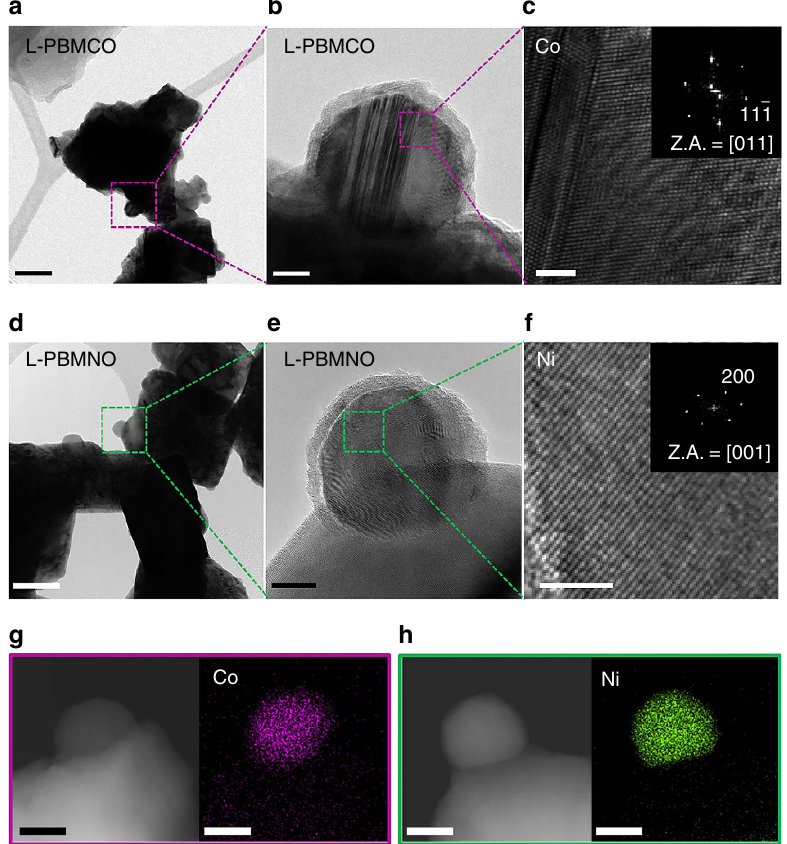
Figure 1 | Transmission electron microscopic analysis. ( a ) A bright-field (BF) TEM image; scale bar, 100nm and ( b ) high-resolution (HR) TEM image of PrBaMn 1.7 Co 0.3 O 5 þ d (L-PBMCO) sample; scale bar 10nm. ( c ) Magnified HR TEM image of exsolved Co nanoparticle; scale bar 2nm, ( d ) BF TEM image; scale bar 100nm and ( e ) HR TEM image of PrBaMn 1.7 Ni 0.3 O 5 þ d (L-PBMNO) sample; scale bar 10nm. ( f ) Magnified HR TEM image of Ni nanoparticle; scale bar 2nm. ( g ) High-angle annular dark-field (HAADF) image of the L-PBMCO with the EDS elemental map of Co; scale bar 25nm. ( h ) HAADF image of the L-PBMNO with the EDS elemental map of Ni; scale bar